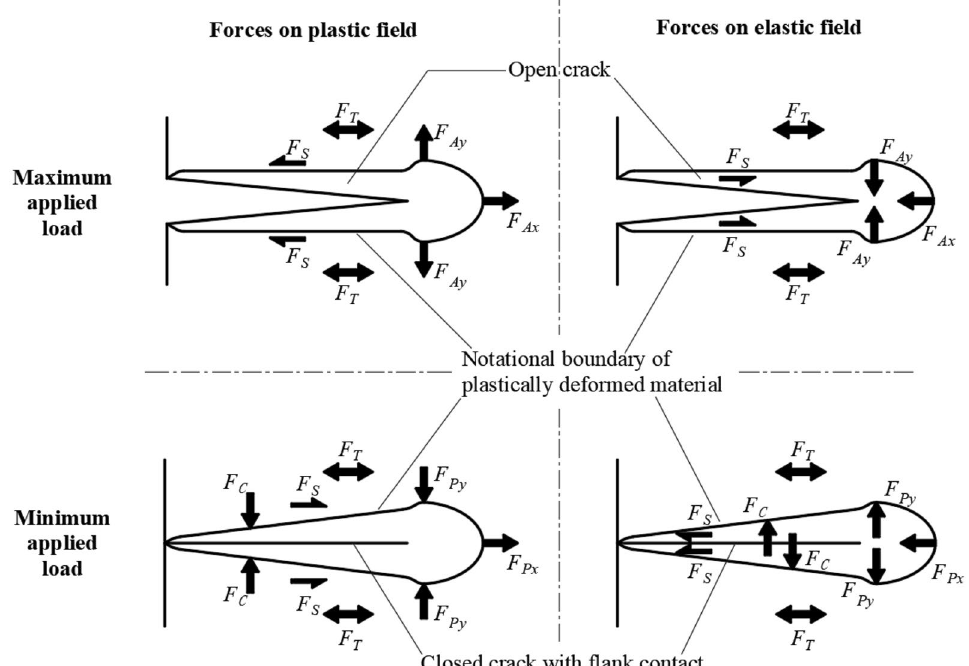
Figure 1 Schematic diagram of crack tip force in the CJP model